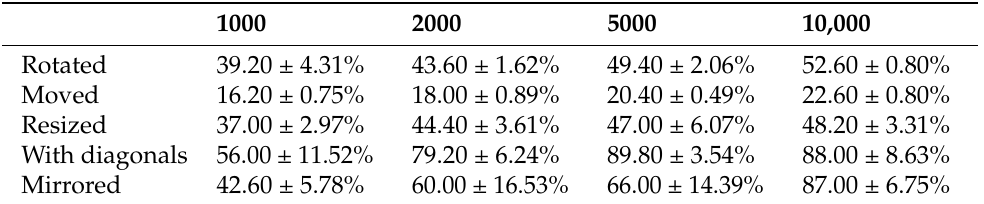
Table 10. The number of transformed objects: 2; Level of noise: 4.